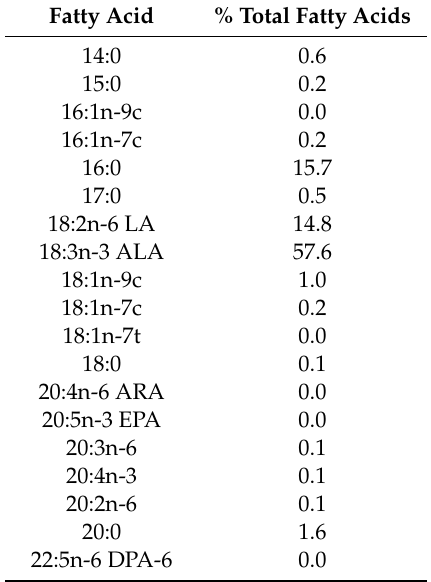
Table 2. Fatty acid composition of grazed ryegrass